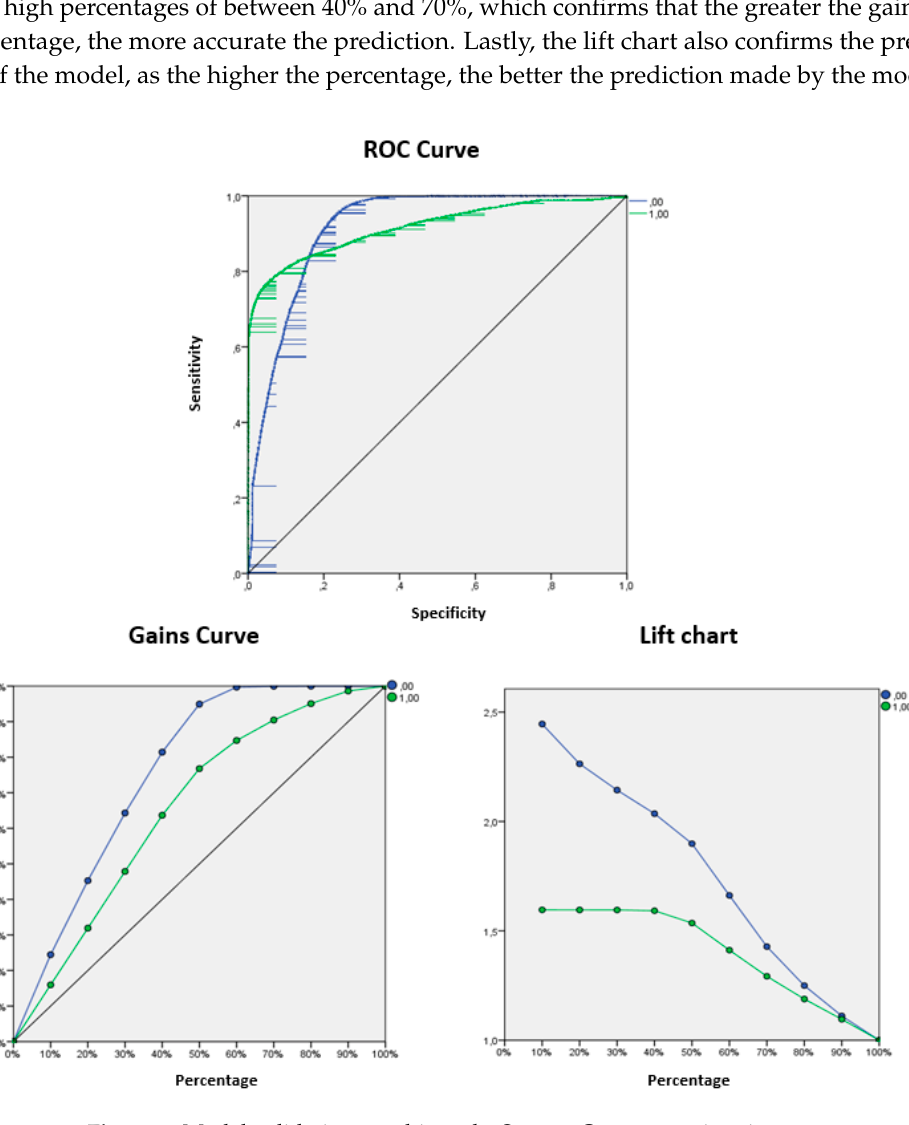
Figure 6. Model validation graphic tools. Source: Our own estimations.